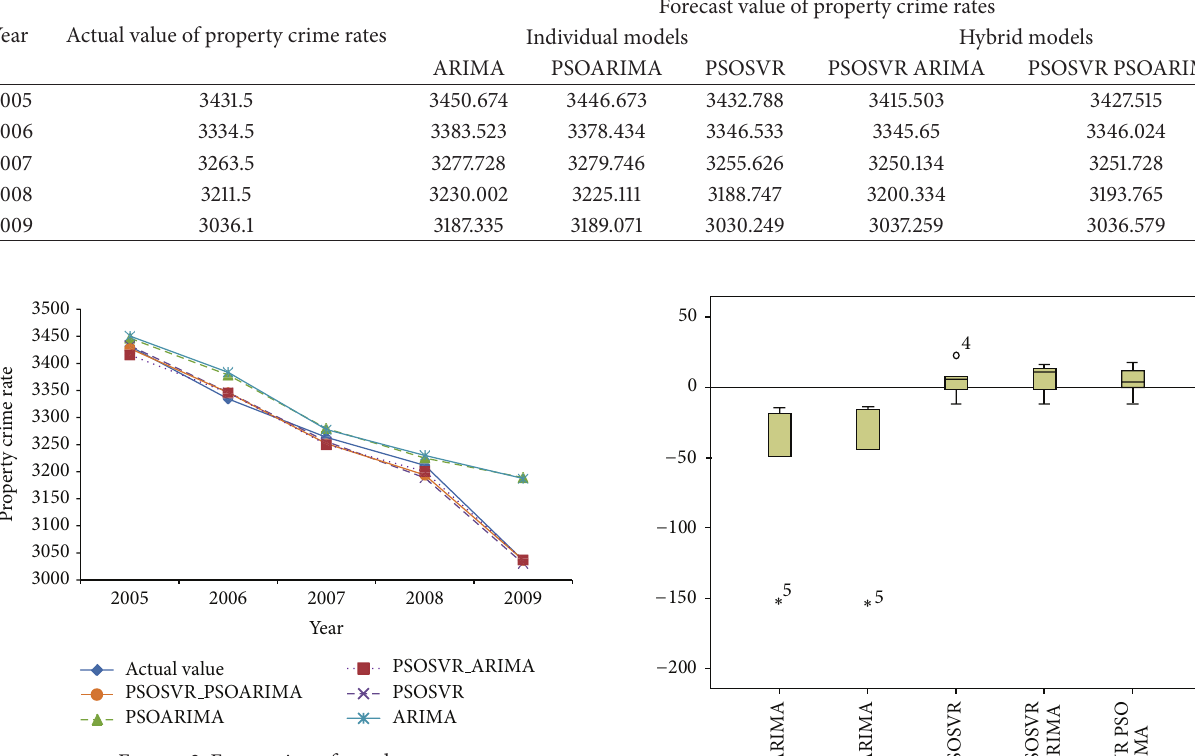
Figure 2: Forecasting of test data set.